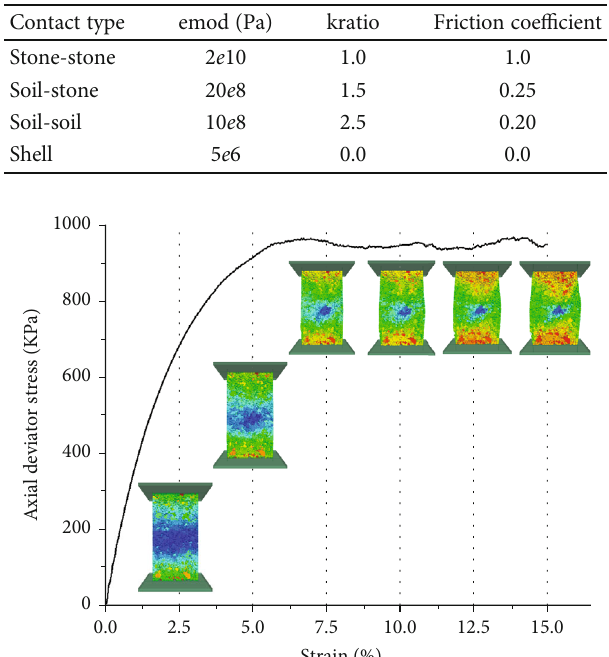
Figure 5: Comparison of laboratory triaxial test results and numerical simulation results of gravel soil mixture. Table 1: Mesoscopic parameters of the discrete element model of gravel soil mixture.